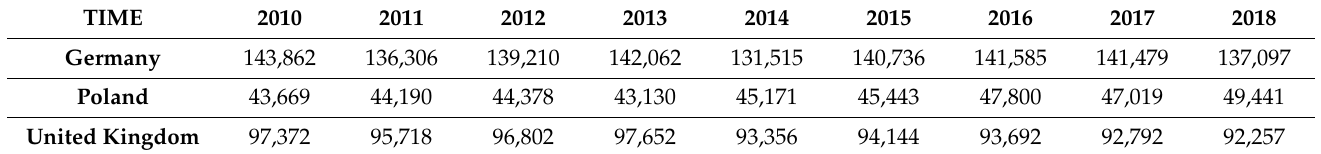
Figure 3. Primary energy consumption in terawatt-hours (TWh)—selected countries. Source: [1]. Table 1. Energy use in commercial and public services (selected countries). Table 1. Energy use in commercial and public services (selected countries).